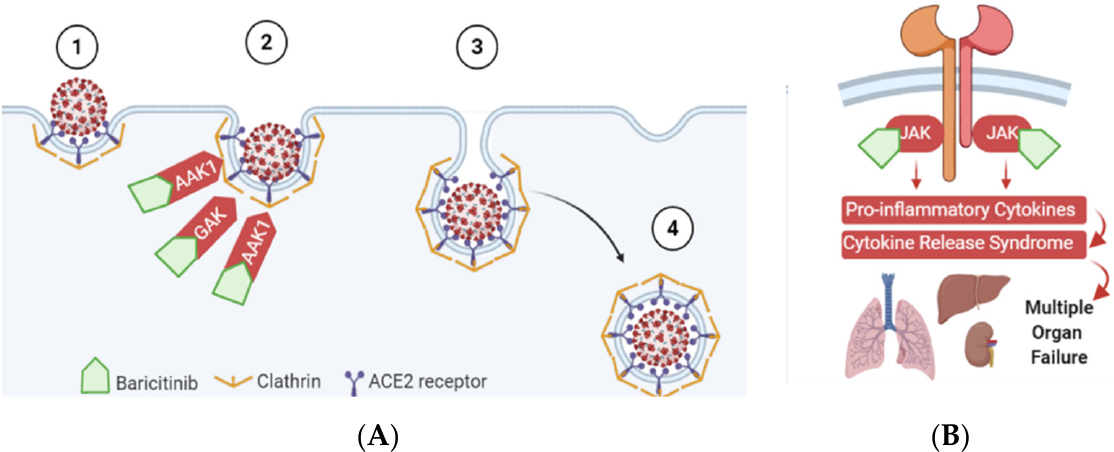
Figure 2. Dual mechanism of action of baracitinib; ( A ) to inhibit clathrin-mediated endocytosis of the SARS-CoV2, and ( B ) to inhibit the JAK-mediate release of pro-inflammatory cytokines. Our transcriptomic analysis of baricitinib-treated model revealed a significant down- regulation of ACE2 and TMPRSS2 in patients treated with baricitinib (Figure 3).